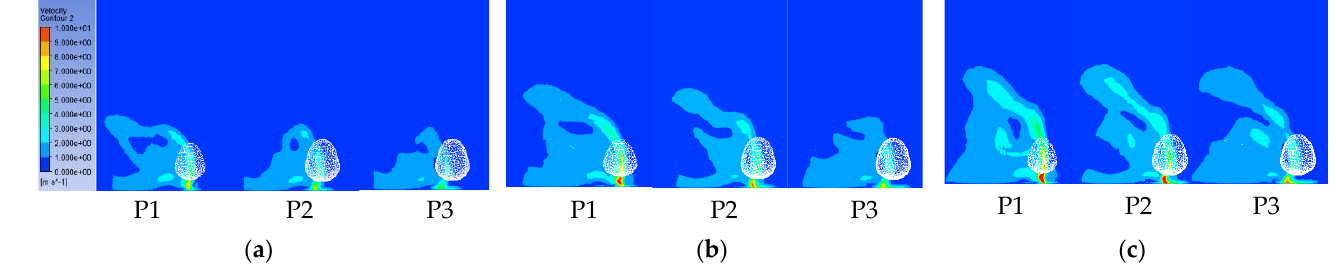
Figure 7. Distribution of airflow in the canopy at different air speeds at the outlet of the fan. ( a ) v = 15 m/s; ( b ) t v = 20 m/s; ( c ) v = 25 m/s.